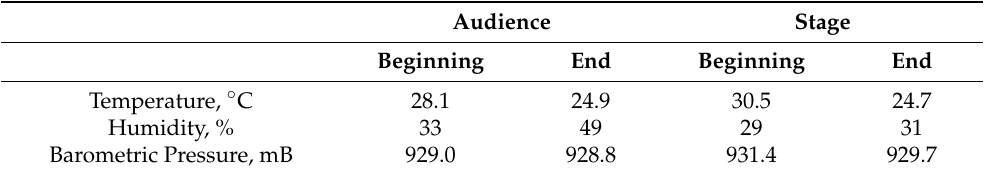
Table 2. Air conditions during the measurement